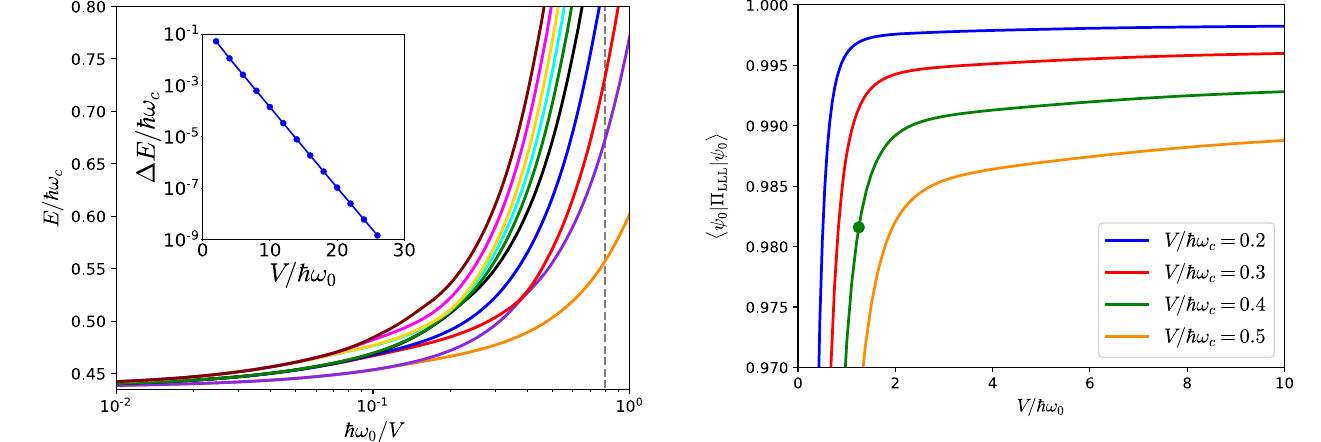
FIG. 4. Lowest ten eigenenergies of the Hamiltonian in Eq. (28) as functions of the confinement strength ℏ ω 0 =V for 0 . 4 . The gray dashed vertical line p=q ¼ 1 = 2 and V= ℏ ω c ¼ marks the value of ℏ ω 0 =V ¼ 0 . 8 that is experimentally relevant for our circuit proposal; see Sec. VI. Inset: Energy gap Δ E ¼ E 1 − E 0 between the two lowest eigenstates for the same values of p=q and V= ℏ ω . For V= ℏ ω 0 ≫ 1 , the energy gap decreases c exponentially with V= ℏ ω 0 .